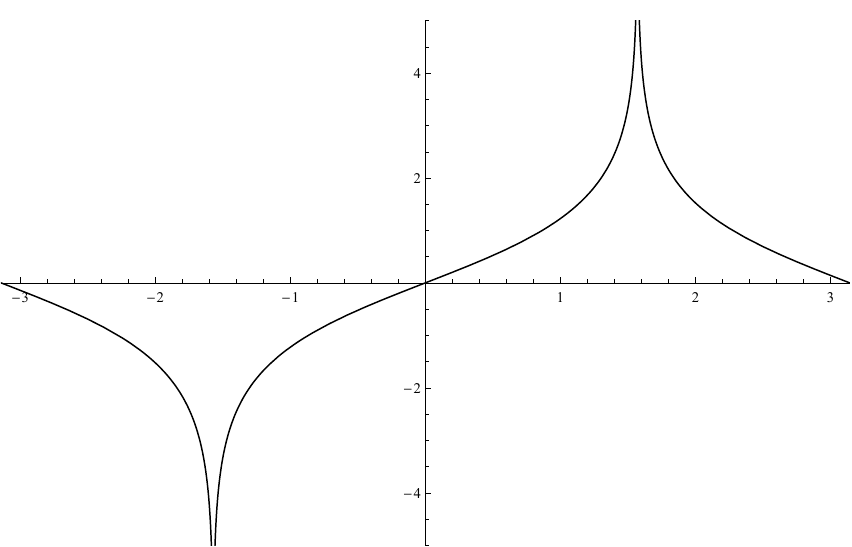
Figure 1 . Plot of the Inverse Gudermannian function gd (cid:0) 1 ( x ) in the fundamental interval ( (cid:0) (cid:25); (cid:25) ). Notice that in the map described by (4.34) the momentum ^ p of the continuum theory ranges from (cid:0)1 to + 1 as p goes from (cid:0) (cid:25) (cid:25) to 3 (cid:25) , so that the map covers the real axis twice as the angular variable ap a a period (see (cid:12)gure